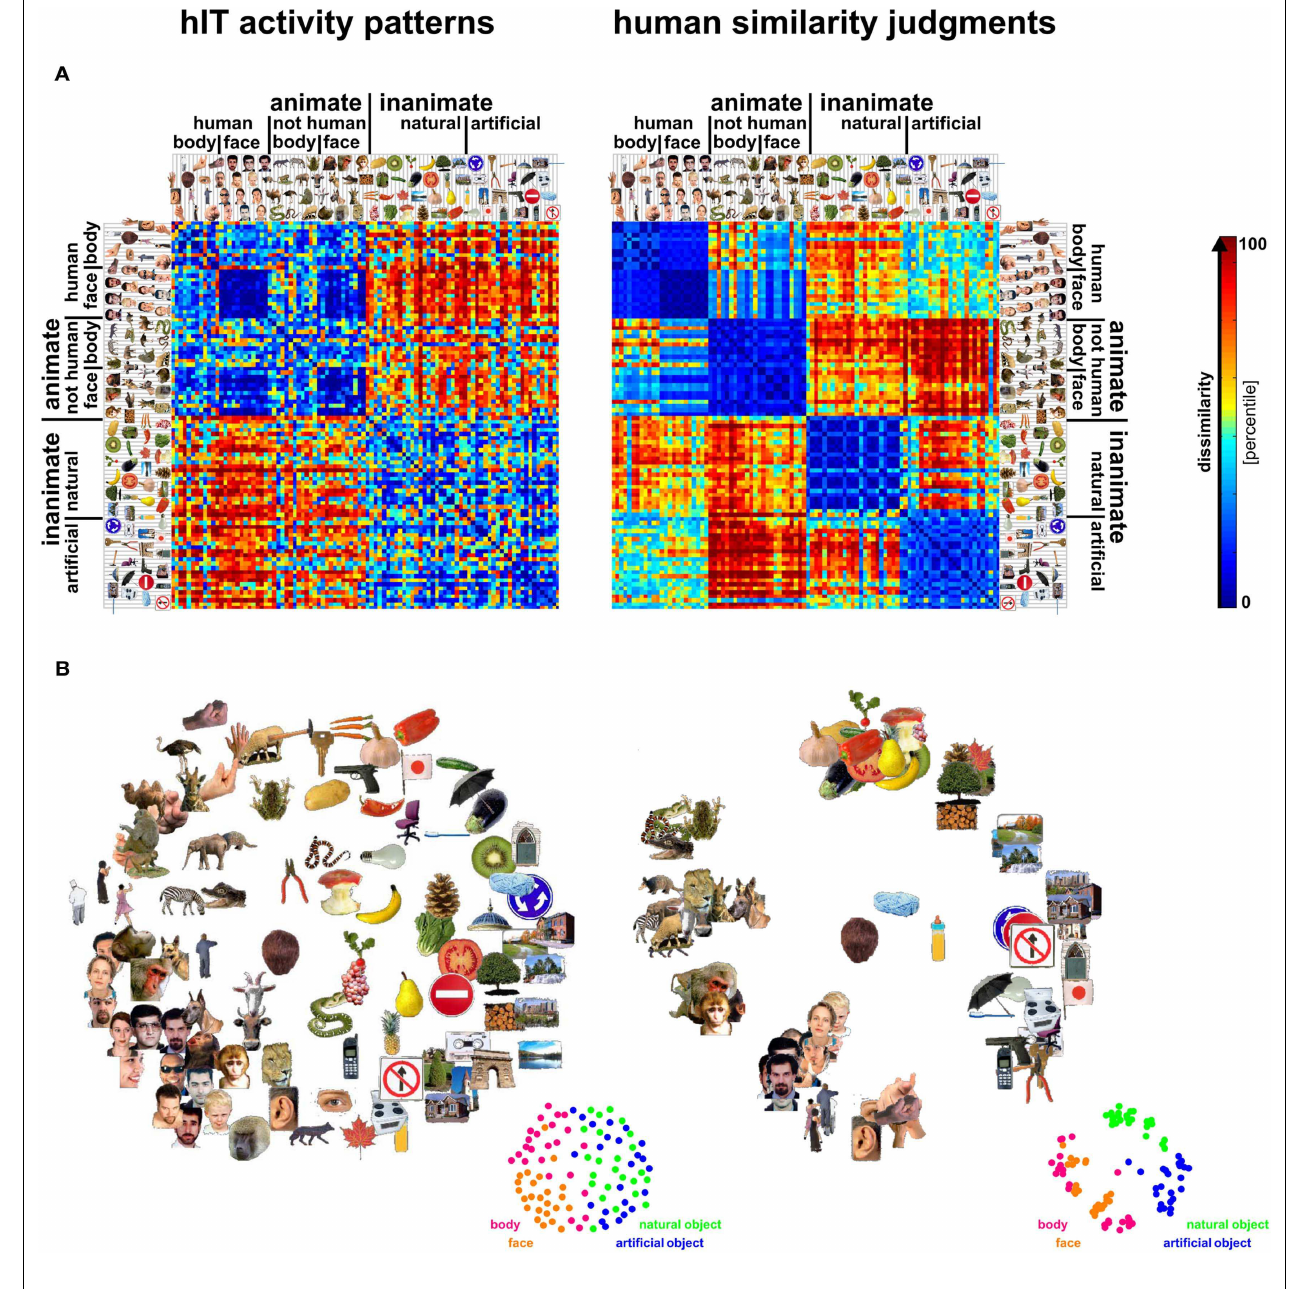
correlation coefficient; 316 most visually responsive bilateral hIT voxels defined using independent data) or judged dissimilarity (relative Euclidean distance as measured by the MA method) for a pair of objects.The matrices were independently transformed into percentiles (see color bar). (B) Multidimensional scaling (MDS; criterion: metric stress) was used to visualize the hIT and judgment similarity representations of the 96 real-world object images. Distances between images reflect the dissimilarities that are shown in the RDMs in (A) : images that elicited similar activity patterns or that were judged as similar are placed close together; images that elicited dissimilar activity patterns or were judged as dissimilar are placed further